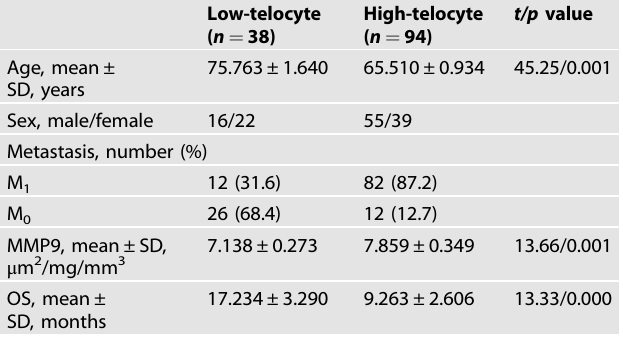
Table 2. Comparison between low and high telocyte groups of HCC patients.